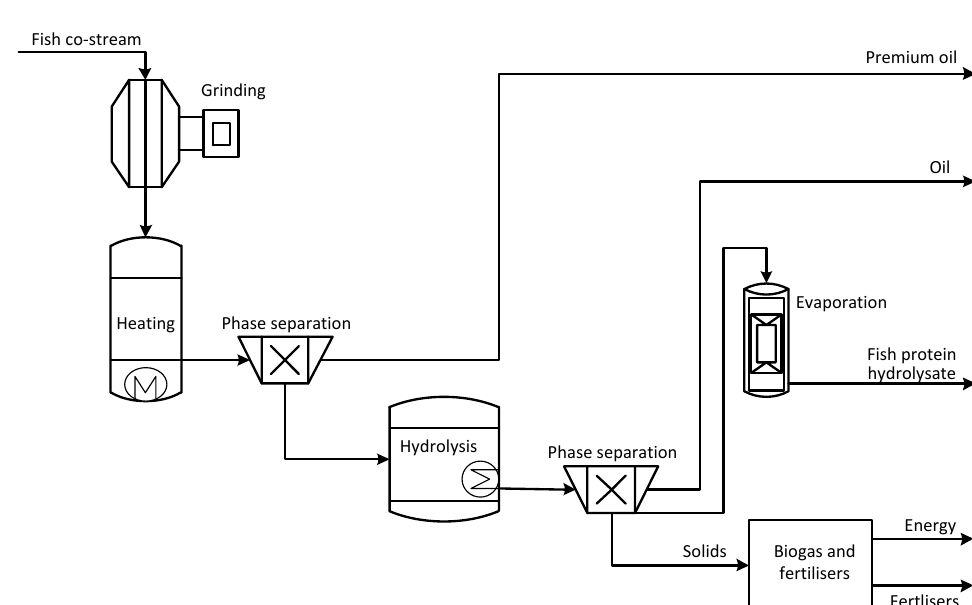
Figure 5. Production of premium oil and fish protein hydrolysate: two-stage processing (IV). The solid residue was transported to the farm. When concept IV is considered the arable land was fertilised with a digestate obtained after anaerobic co-digestion of mixtures from fish backbones and cattle manure. However, the volume of residue was much smaller than in concept I, and so additional mineral fertilisers are needed.